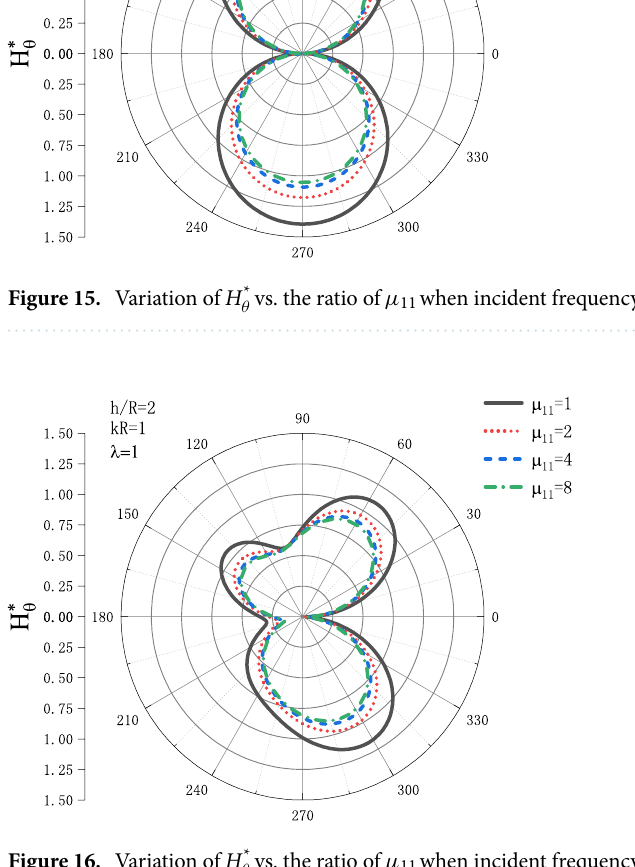
Figure 16. Variation of H